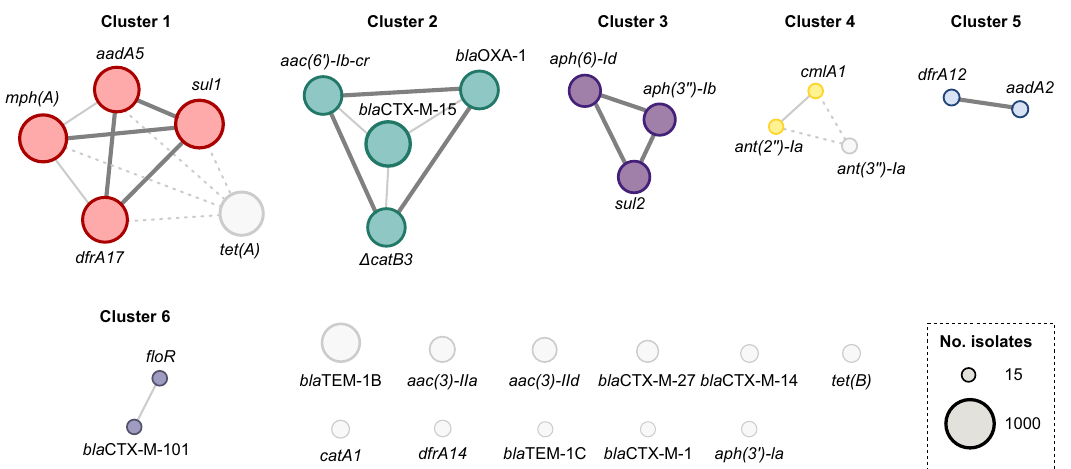
Fig. 2 Co-occurrence network graph of antimicrobial resistance genes (ARGs). ARGs occurring in at least 15 isolates are shown. Circle sizes correspond to the number of occurrences. Co-occurring genes are connected according to the co-occurrence level in thick (Jaccard distance [JD] < 0.15 [commonly co-occurring]), thin (JD 0.15 – 0.3), or dashed (JD 0.3 – 0.5) lines.